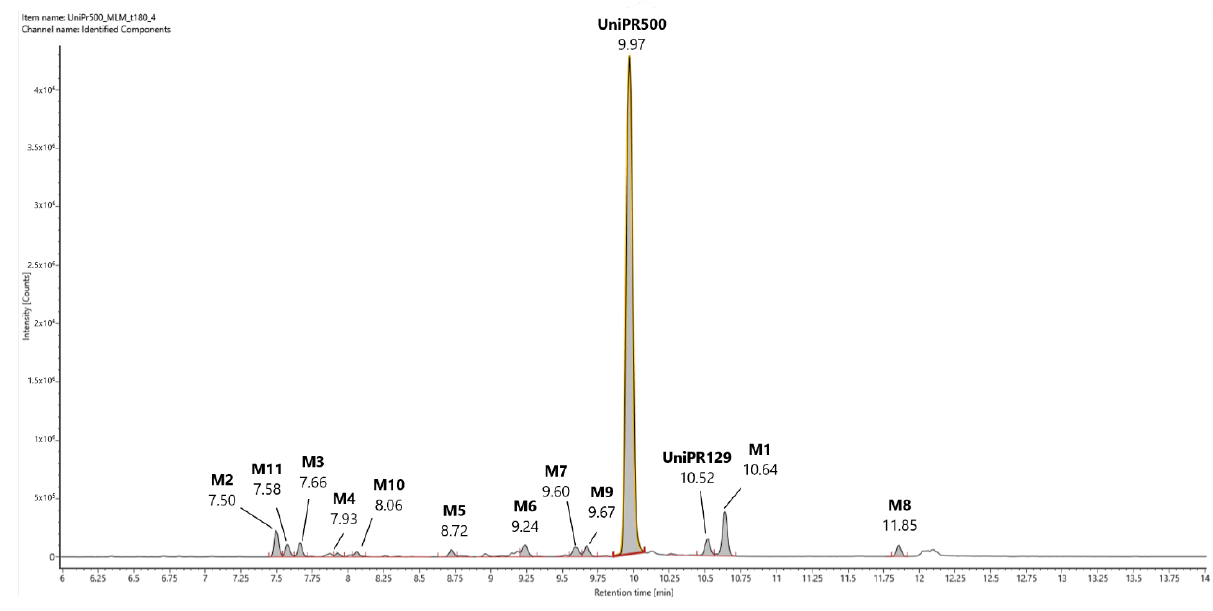
Figure 7. Representative UHPLC-HR-MS chromatogram in positive electrospray ionization (ESI + ) of a MLM incubation of UniPR500 (100 μM) ( t = 180 min).